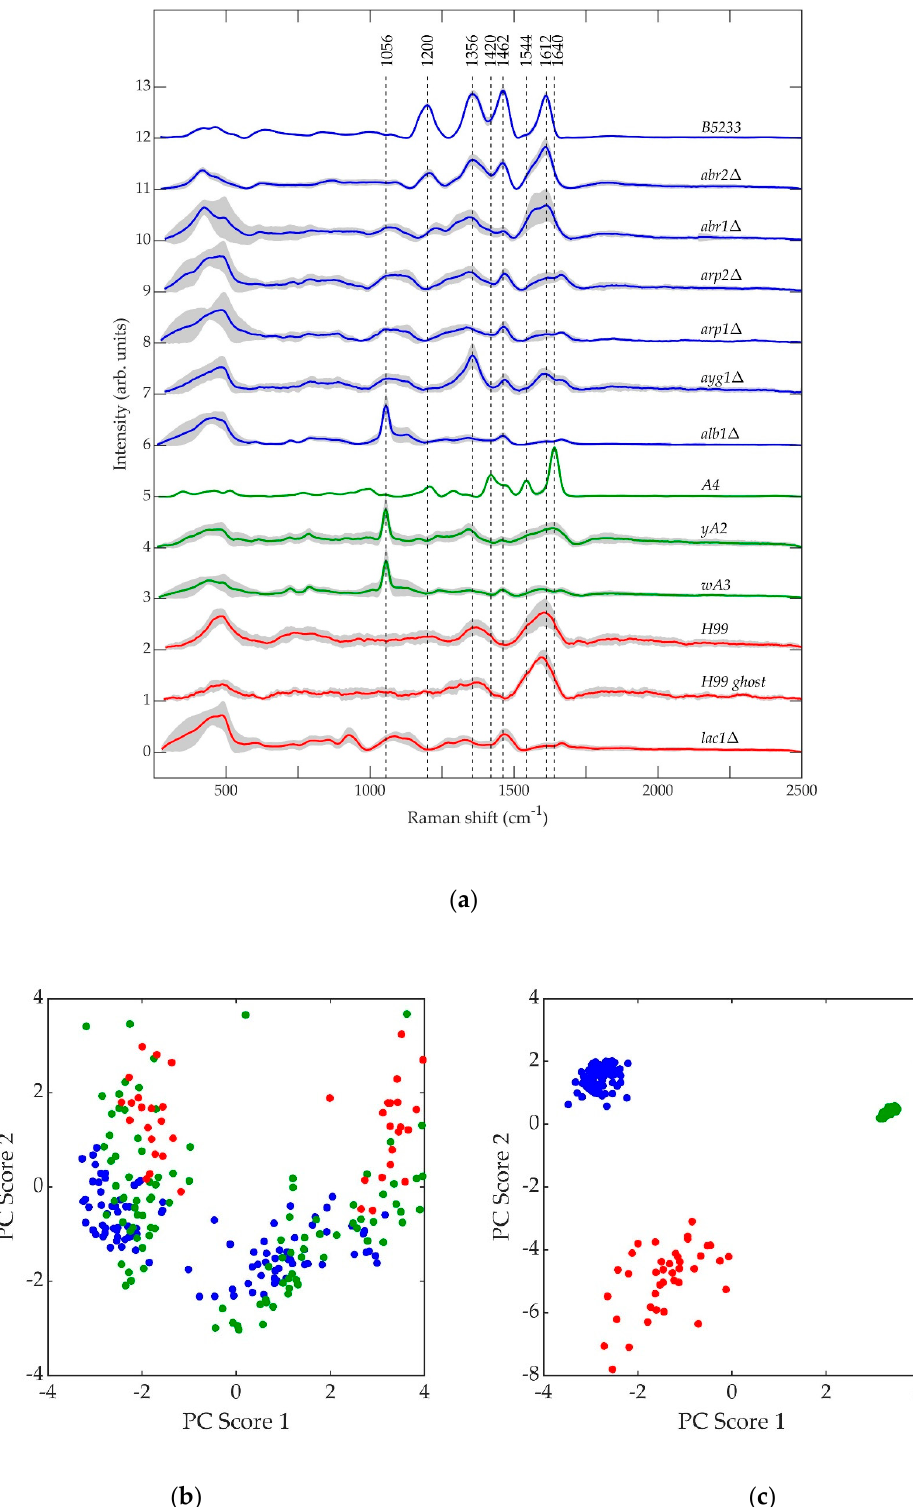
Figure 9. ( a ) Average normalized retrieved pure Raman spectra of A. fumigatus (blue), A. nidulans (green), and C. neoformans (red) strains. ( b ) Principal component scores of mutant strains at the beginning of each biosynthetic pathway: alb1 ∆ (blue), wA3 (green), and lac1 ∆ (red). ( c ) Principal component scores of strains at the end of each biosynthetic pathway: B5233 (blue), A4 (green), and H99